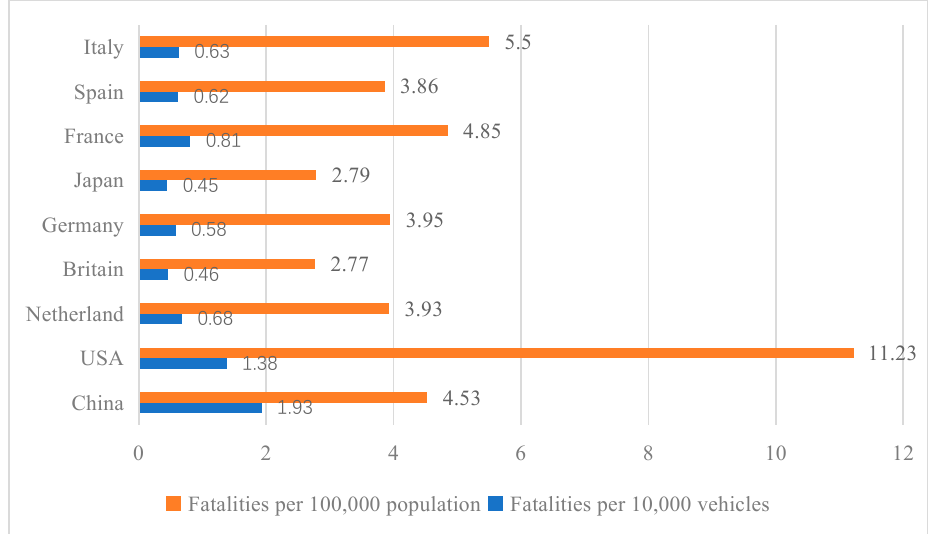
Figure 6. Comparisons of fatality rates between China and developed countries.